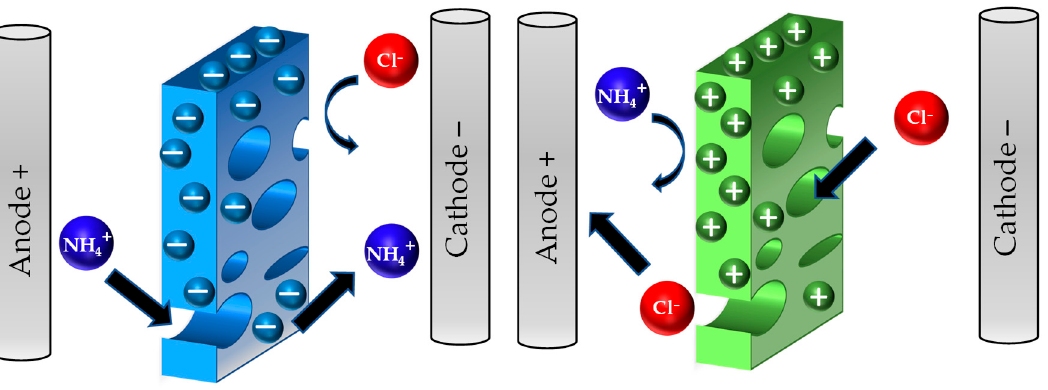
Figure 12. Simplified illustration of an electrochemical membrane system for nitrogen recovery. Table 7. Nitrogen recovery and energy requirements of ECMs.